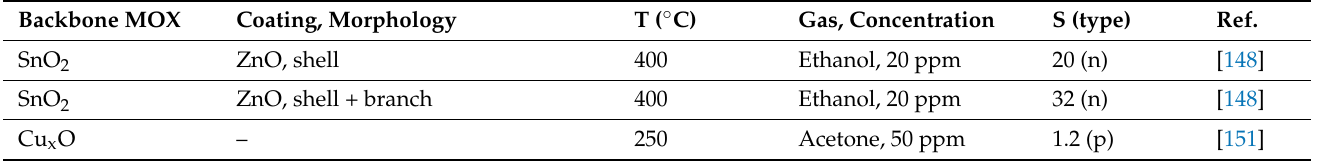
Table 5. Chemiresistors based on branched metal oxide (MOX) nanostructures. The response intensity S is calculated as S = R gas /R air for NO 2 and as S = R air /R gas for other compounds in the case of n-type sensing response. The contrary is in the case of p-type sensing response. The n- or p- type response is reported in the S column. Gas concentrations are expressed in parts per million (ppm) and the sensor temperature is